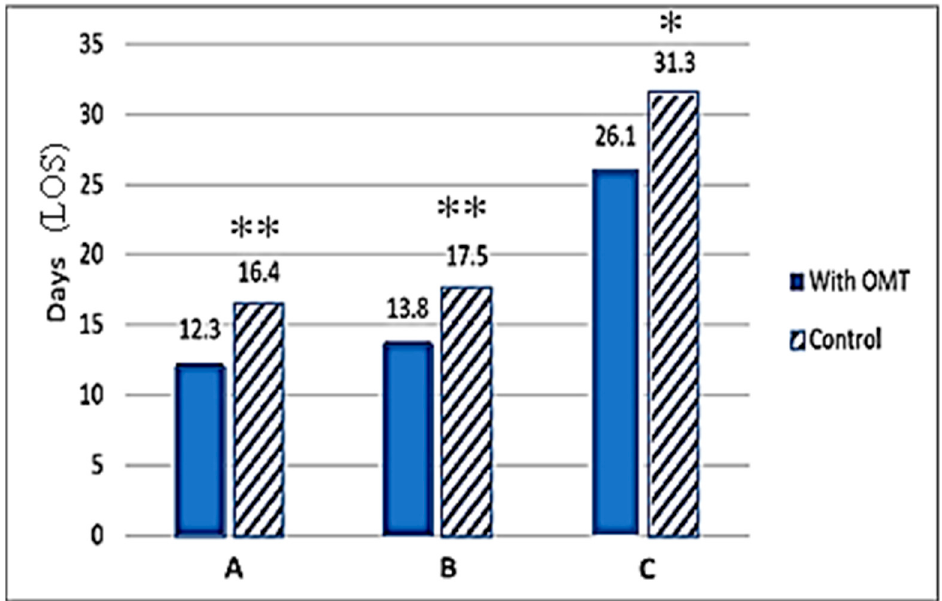
Figure 3. Effect of adjunct OMT on length of hospital stay (LOS). The number of days of NICU stay are presented on the X-axis. The hospital stays (days) are also presented at the top of each bar graph. Hatched bars represent control (no OMT), and solid bars show data obtained in the OMT group. Significant differences between control (non-OMT) and the experimental (with OMT) groups are designated by asterisk above the bars. Data represents published findings from ( A ) Pizzolorusso G. et al. (2014) [75] with ** denoting p < 0.001, ( B ) Cerritelli F. et al. (2015) [42] with ** denoting p < 0.001, and ( C ) Cerritelli F. et al. (2013) [76] with * denoting p < 0.03.